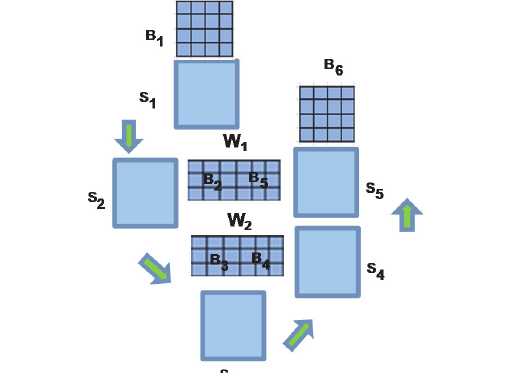
Fig. 7. Non-sequential and sequential buffer clusters maintaining sequence of